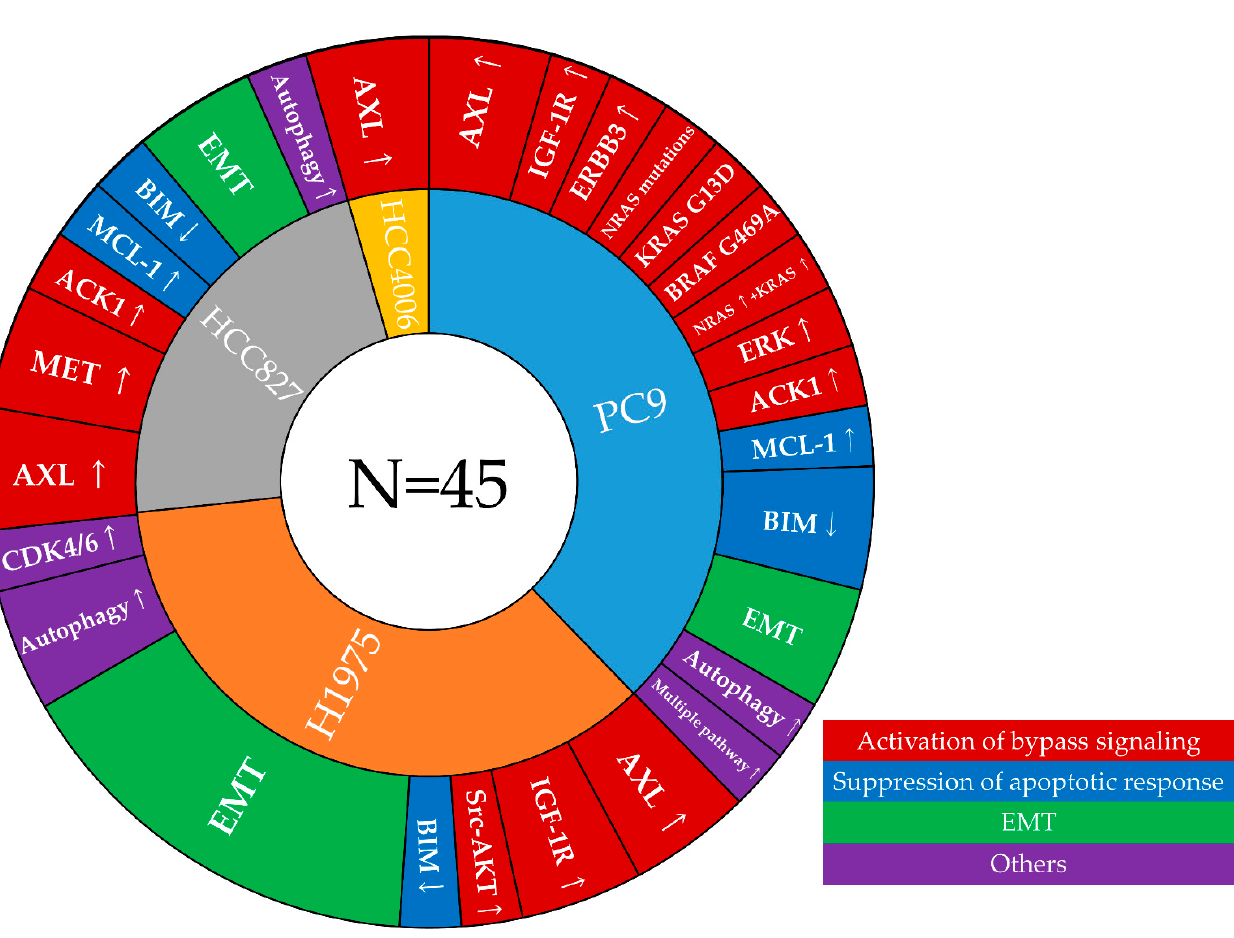
Figure 1. Mechanisms of acquired resistance to first-line osimertinib that were identified in cell line models [32–46,48,50–60]. This graph is color-coded by cell line models and mechanisms of resistance to first-line osimertinib. EGFR, epidermal growth factor receptor; AXL, AXL receptor tyrosine kinase; ERBB3, human epidermal growth factor receptor-3; IGF1R, insulin-like growth factor-1 receptor; TGF, transforming growth factor; ACK1, activated Cdc42-associated kinase-1; CDK4/6, cyclin-dependent kinase; BCL-2, B-cell lymphoma-2; YAP, yes-associated protein; ANKRD1, ankyrin repeat domain-1; IRE1 α , inositol-requiring enzyme-1 α